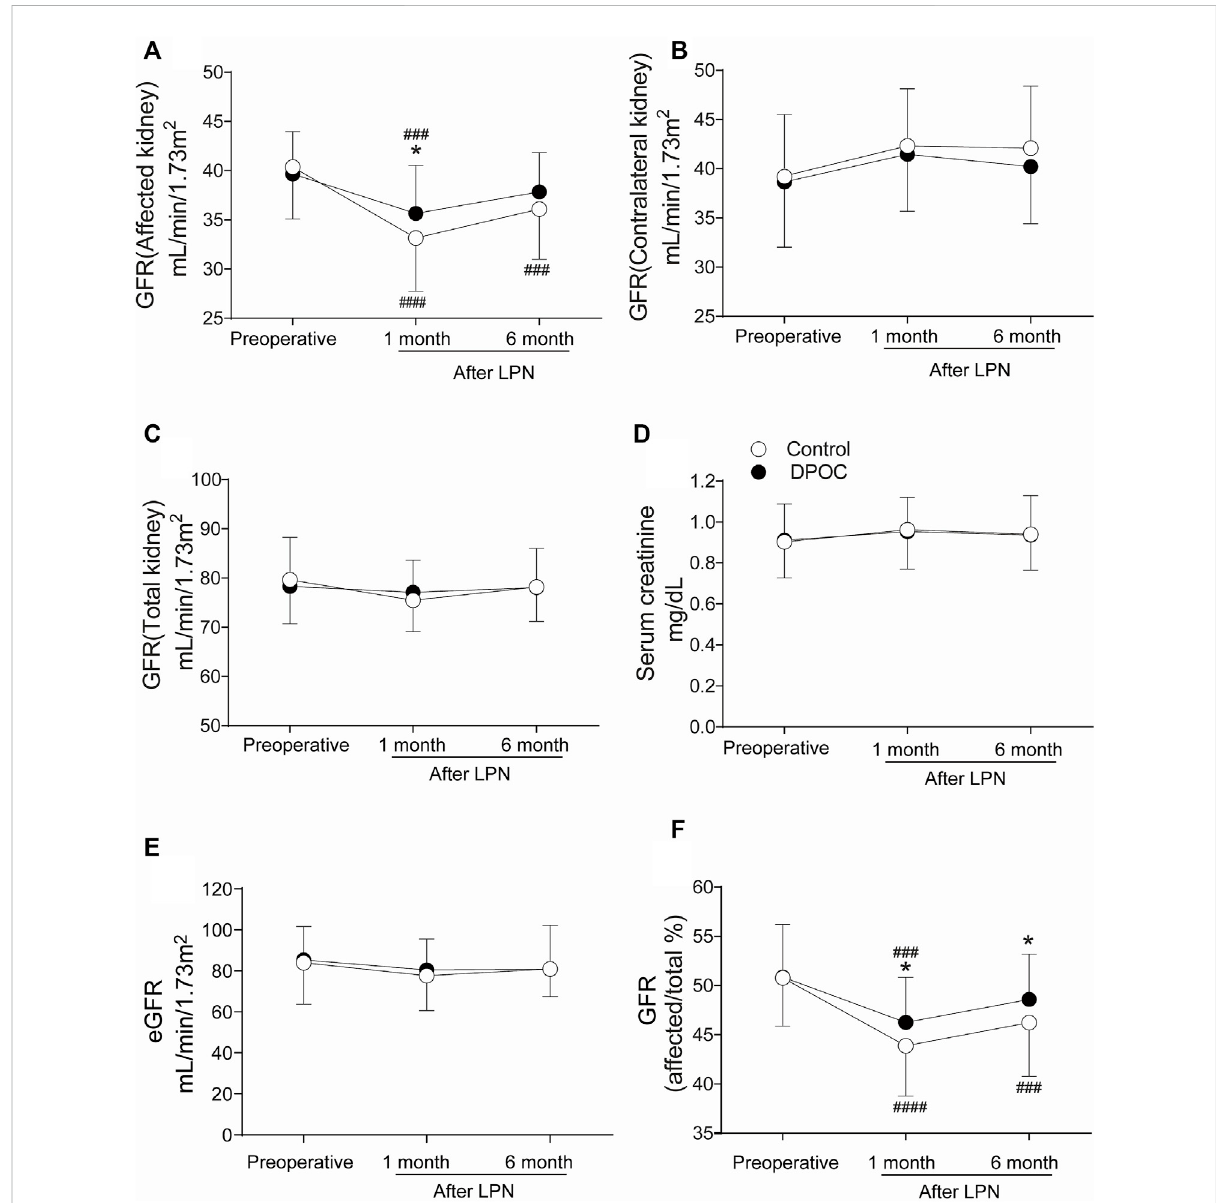
FIGURE 3 Renal function at one and 6 months after LPN between DPOC or control group. (A) GFR of the affected kidney; (B) GFR of the contralateral kidney; (C) GFR of the total kidney; (D) Serum creatinine; (E) Estimated glomerular fi ltration rate (eGFR); (F) Contribution change of the